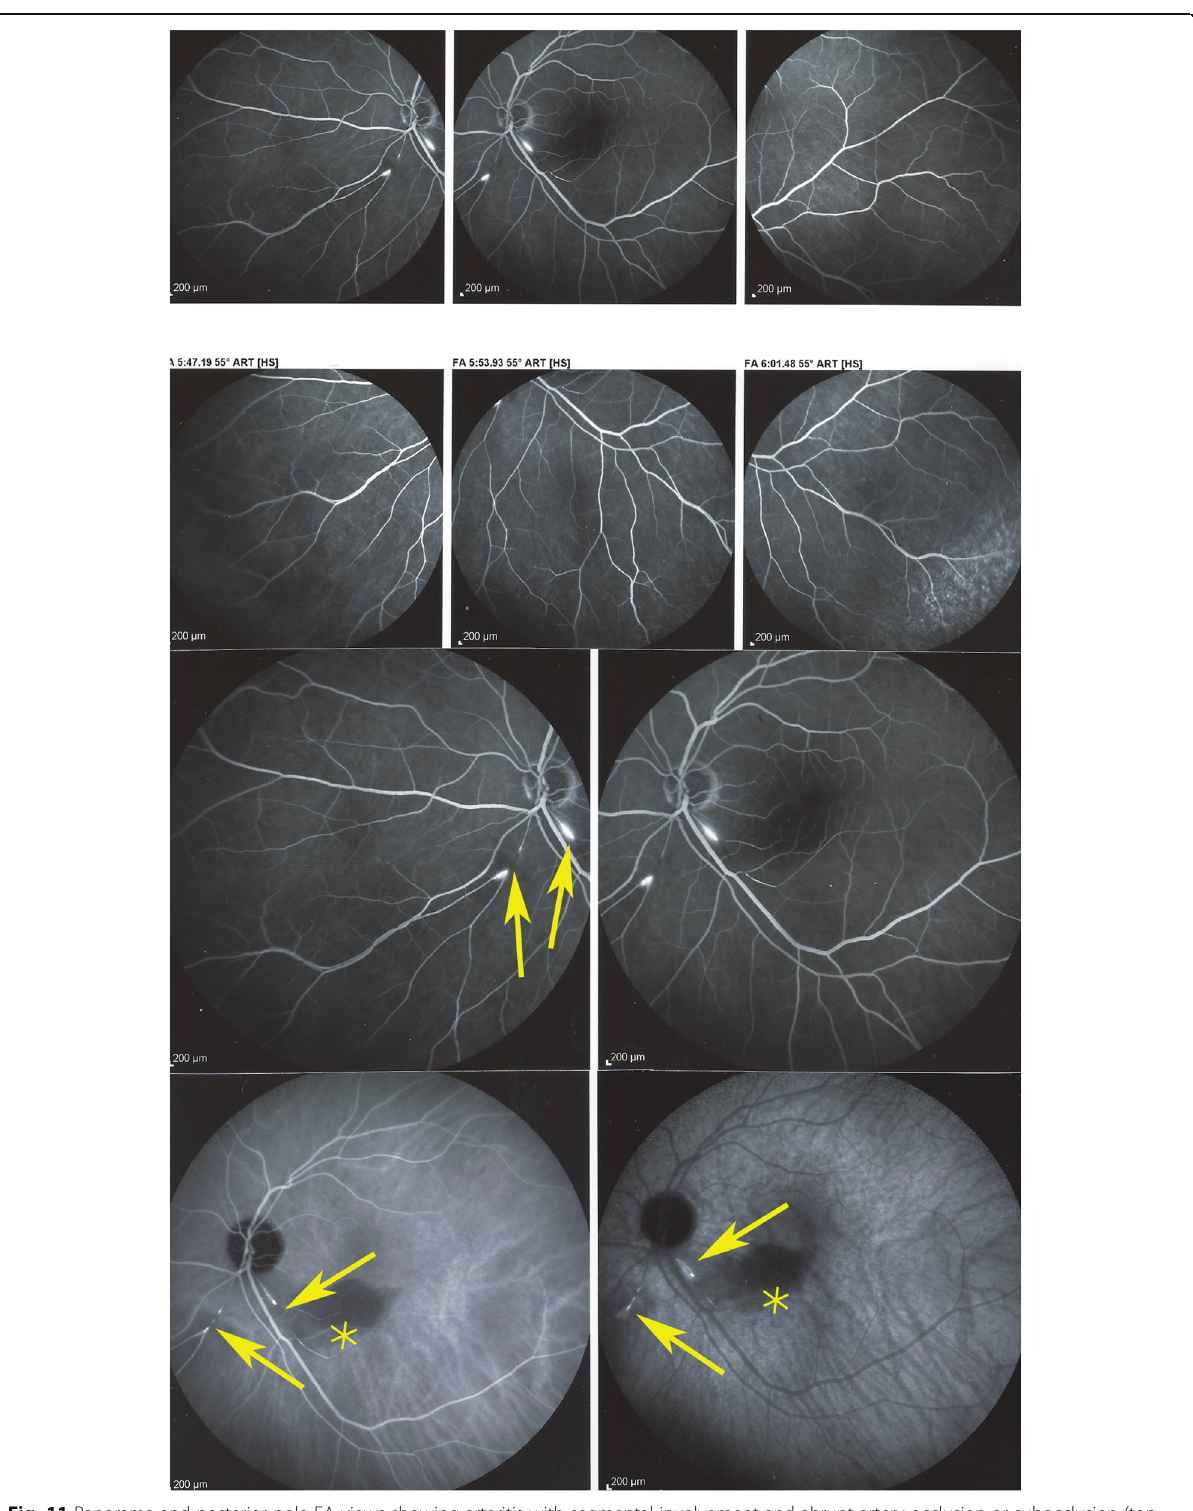
Fig. 11 Panorama and posterior pole FA views showing arteritis with segmental involvement and abrupt artery occlusion or subocclusion (top sextet of frames). Posterior pole FA and ICGA views showing hyperfluorescence of the arteries on both FA (top two frames) and ICGA (bottom two frames) (arrows) and hypofluorescence in the areas of retinal infarction (asterisk) (bottom quartet of frames) (case